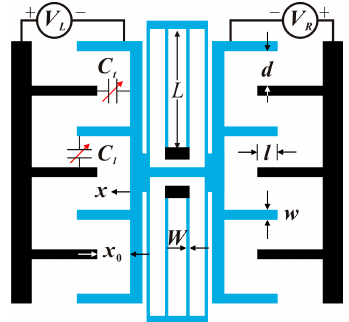
Figure 1. Schematic diagram of a folded ‐ microelectromechanical systems (MEMS) comb drive resonator [7].